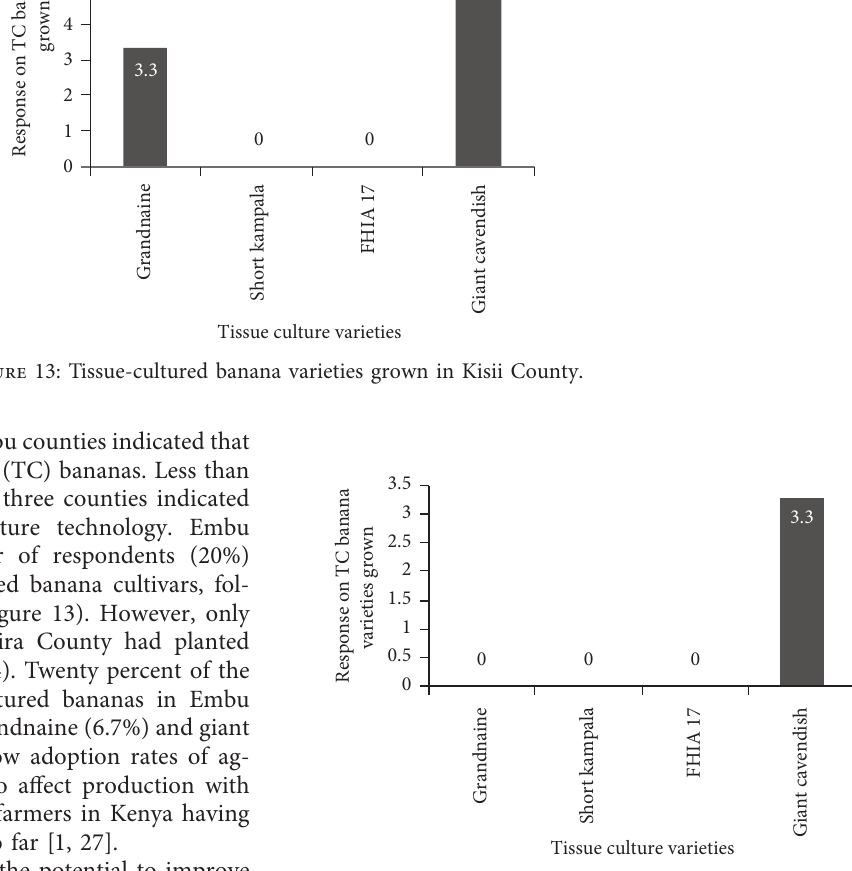
Figure 14: Tissue-cultured banana varieties grown in Nyamira